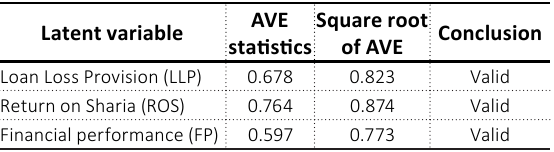
Table 4. Fornell-Larcker criteria